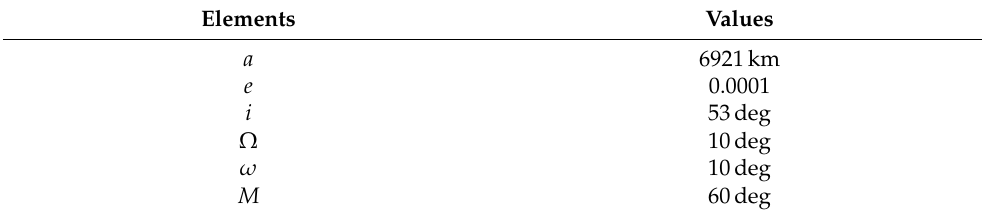
Table 1. Initial mean elements.